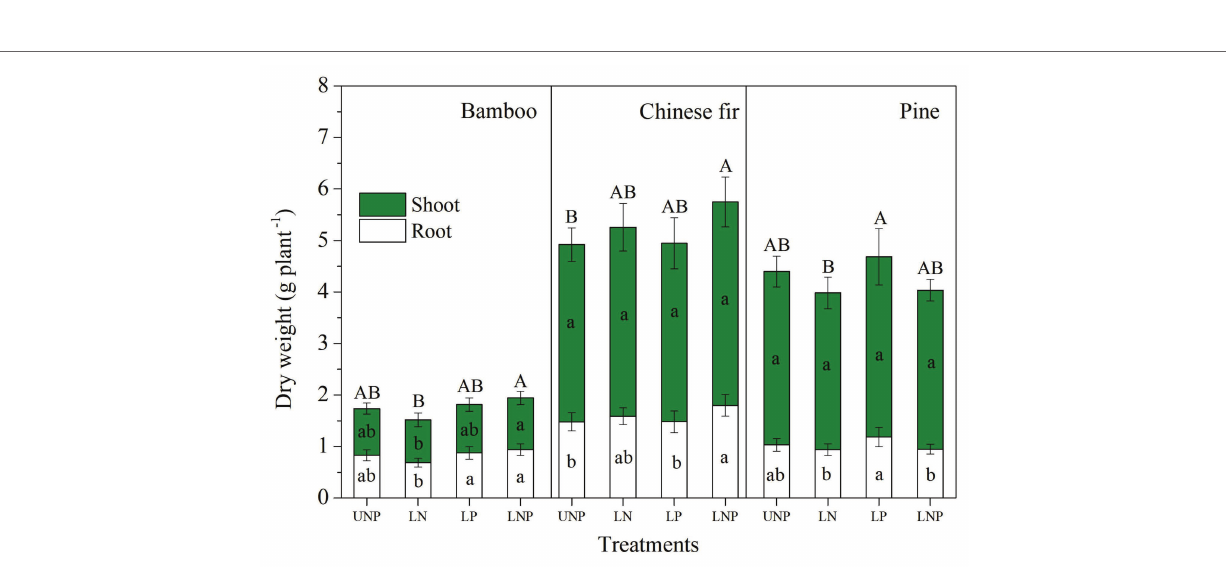
FIGURE 3 | Effects of different nutrient supply treatments on the root surface areas of the three tree species in each layer. Different lowercase letters denote significant differences within the same category (soil layer) for each species among treatments ( p < 0.05). Different capital letters denote significant differences in the total root surface area for each species among treatments ( p < 0.05).